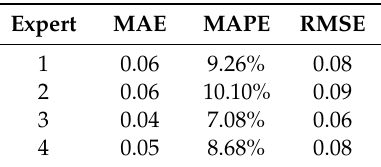
Table 5. Forecasting performances for Chen and Lin method if experts did not collaborate.